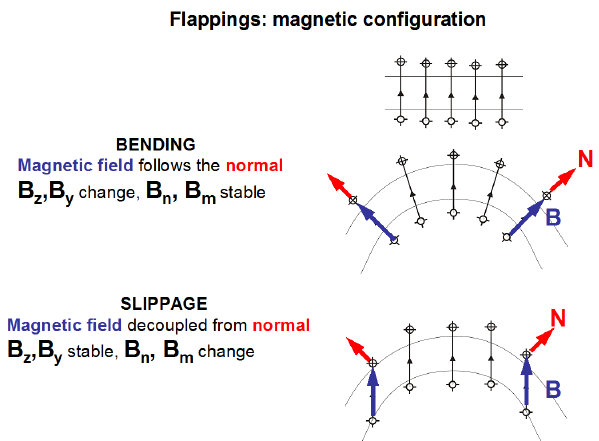
Fig. 1. Two variants of the cross-tail current sheet deformation, shown in a sunward view in YZ GSM plane, with B y = 0. See text for details. Modified from Petrukovich et al.